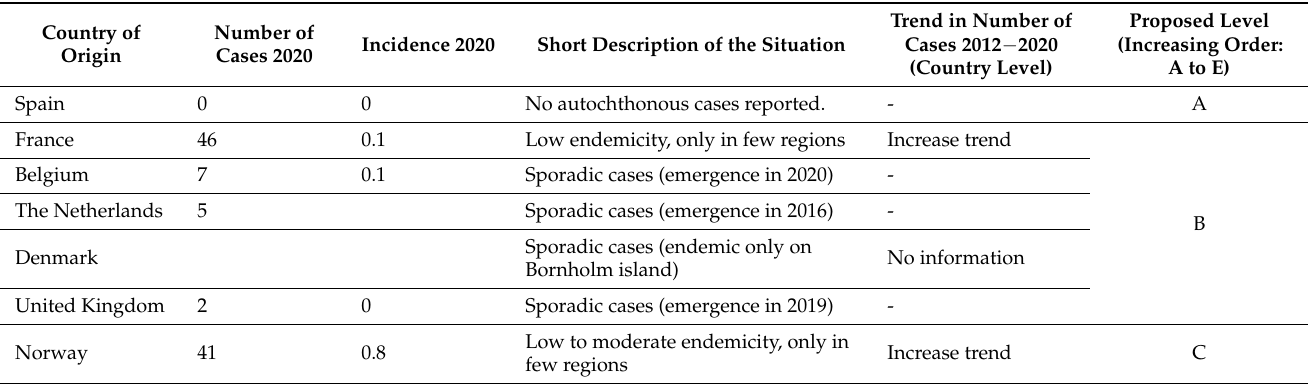
Table A3. Grouping of Countries of Origin of the Elicited Experts based on Level of Endemicity Regarding the Tick-Borne